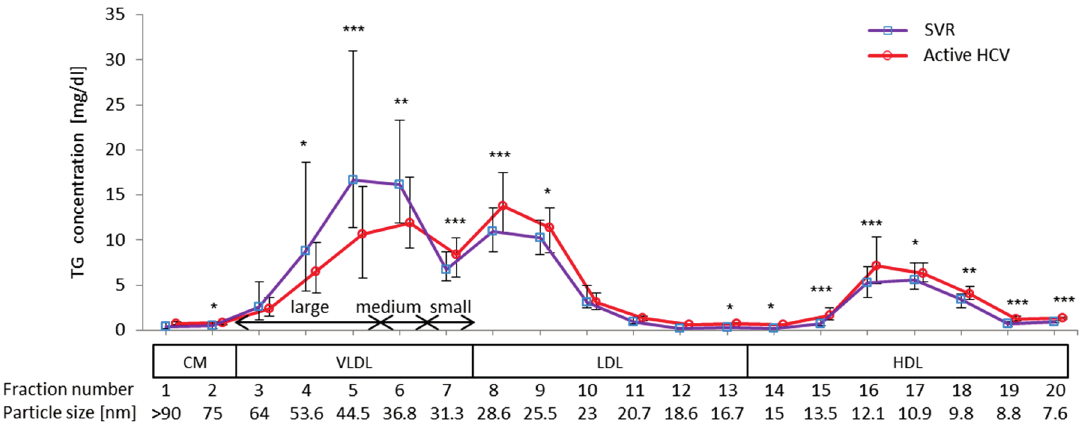
Figure 1. Comparison of triglyceride (TG) concentrations in lipoprotein sub-fractions between active HCV and SVR groups. Serum lipoprotein was fractionated by HPLC into 20 fractions according to the particle size, and the concentration of TG in each fraction was measured using an online detection system (Skylight Biotech, Inc., Akita, Japan). The fraction number and the mean particle size are shown at the bottom of the image ( * p < 0.05; ** p < 0.01; *** p < 0.001). 2.3. Impact of Chronic Active HCV G1b Infection on the Concentration of TG in the Four Major Classes of